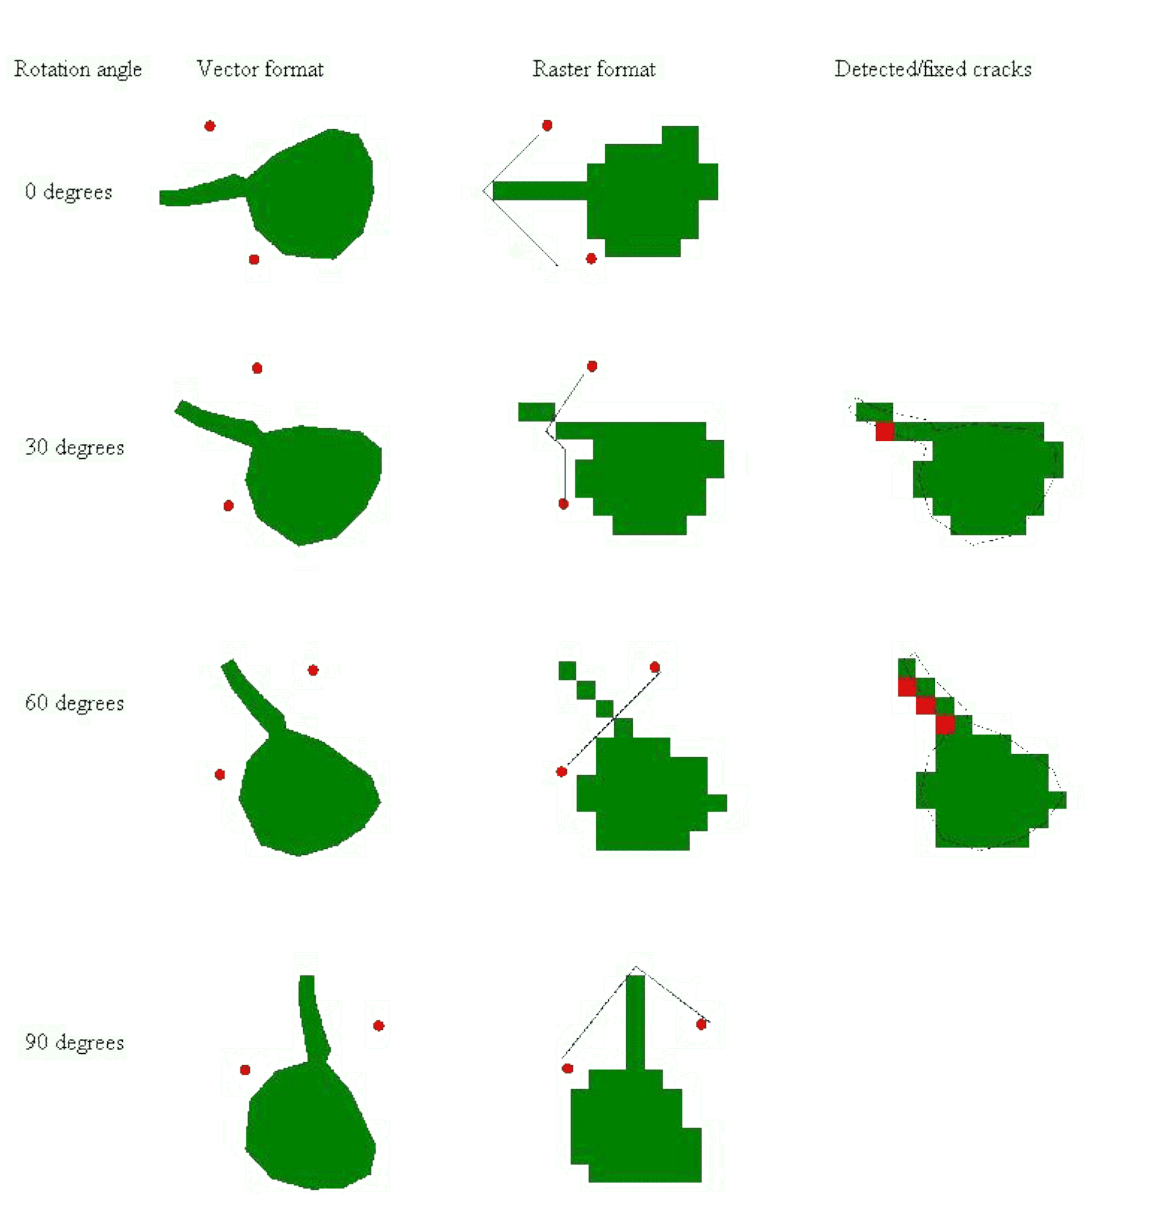
Fig. 2 . The green zones represent costly kidney-shaped wetlands surrounded by an easily traversable landscape. The red points represent the beginning and desired end points for a travelling organism. The first column shows the rotation of the wetlands relative to the original orientation (0°) of the wetland. The second column represents the same wetlands in a raster format where the blue lines show the least-cost paths between the red points. In the third column, red cells indicate the cracks (which would subsequently be filled). The dashed black lines indicate the original wetland